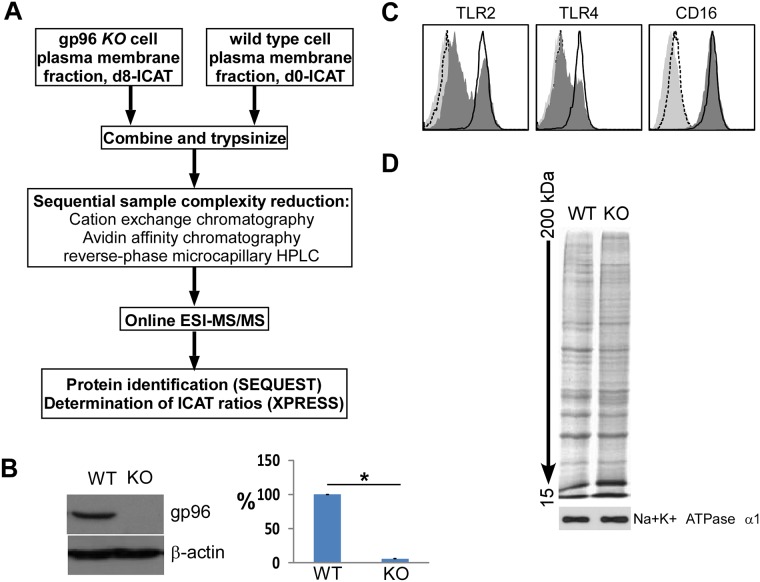
Proteomic analysis of plasma membrane proteins of macrophages whose expression is dependent on gp96.A) Schematic of ICAT-based method. B) IB of gp96 andβ–actin from WT and KO Mø. Quantitated data were shown in the bar graph. *p<0.01. Data represent three western blot results. Error bars denote s.e.m. C) Flow cytometric analysis of cell surface TLRs and CD16 (WT: open; KO: filled dark). The dashed and light histograms represent isotype stains. D) SDS-PAGE and silver staining of membrane proteins. The plasma membrane protein, Na+K+ATPase α1, was immunoblotted as a loading control.